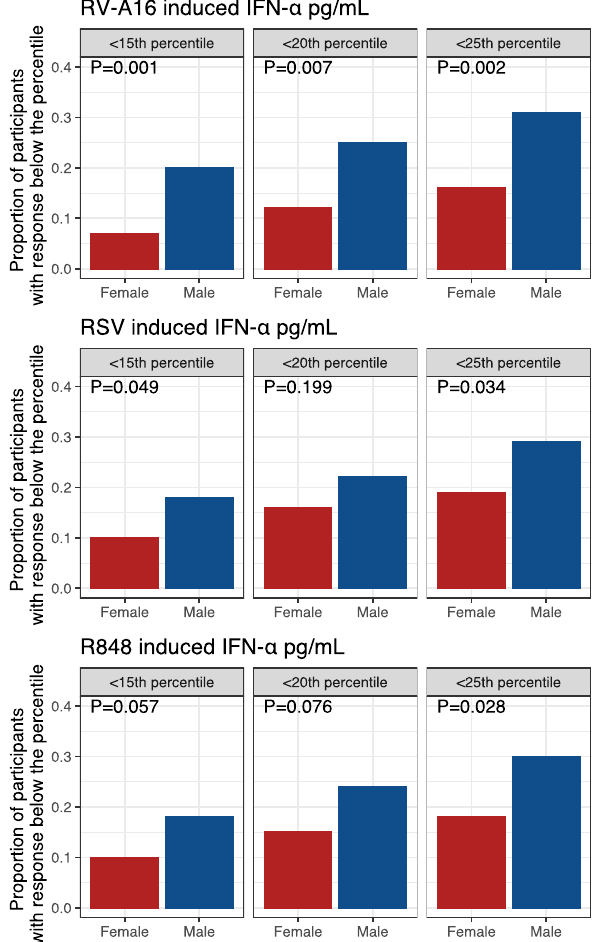
Figure 5. Proportions of males and females with IFN responses to RV-A16, RSV and R848 below the 15th, 20th and 25th percentiles of the entire population. P -values are derived using chi-squared test.